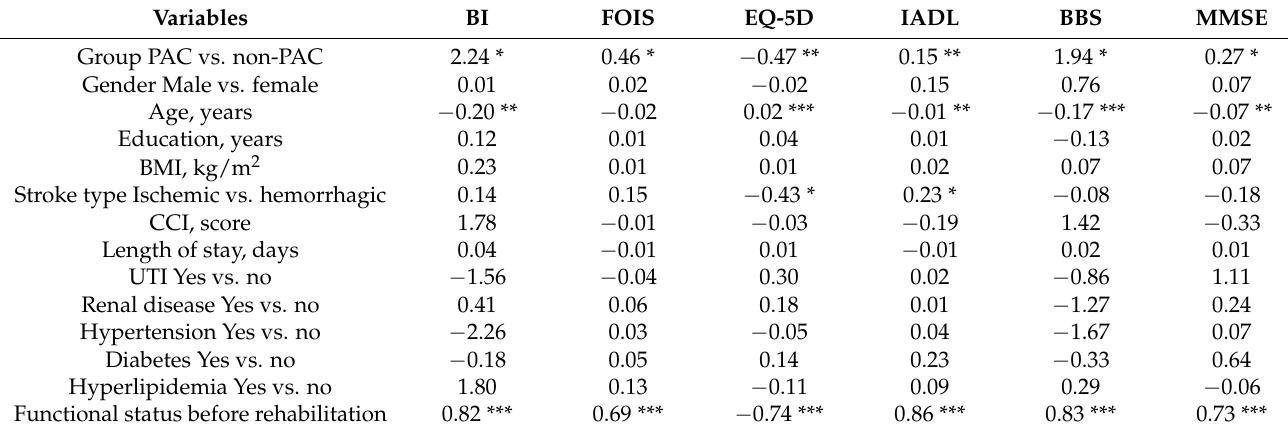
Table 3. Coefficients of GEE models of effective predictors of each functional status measure in patients with stroke over a 1-year period after propensity score matching ( n =